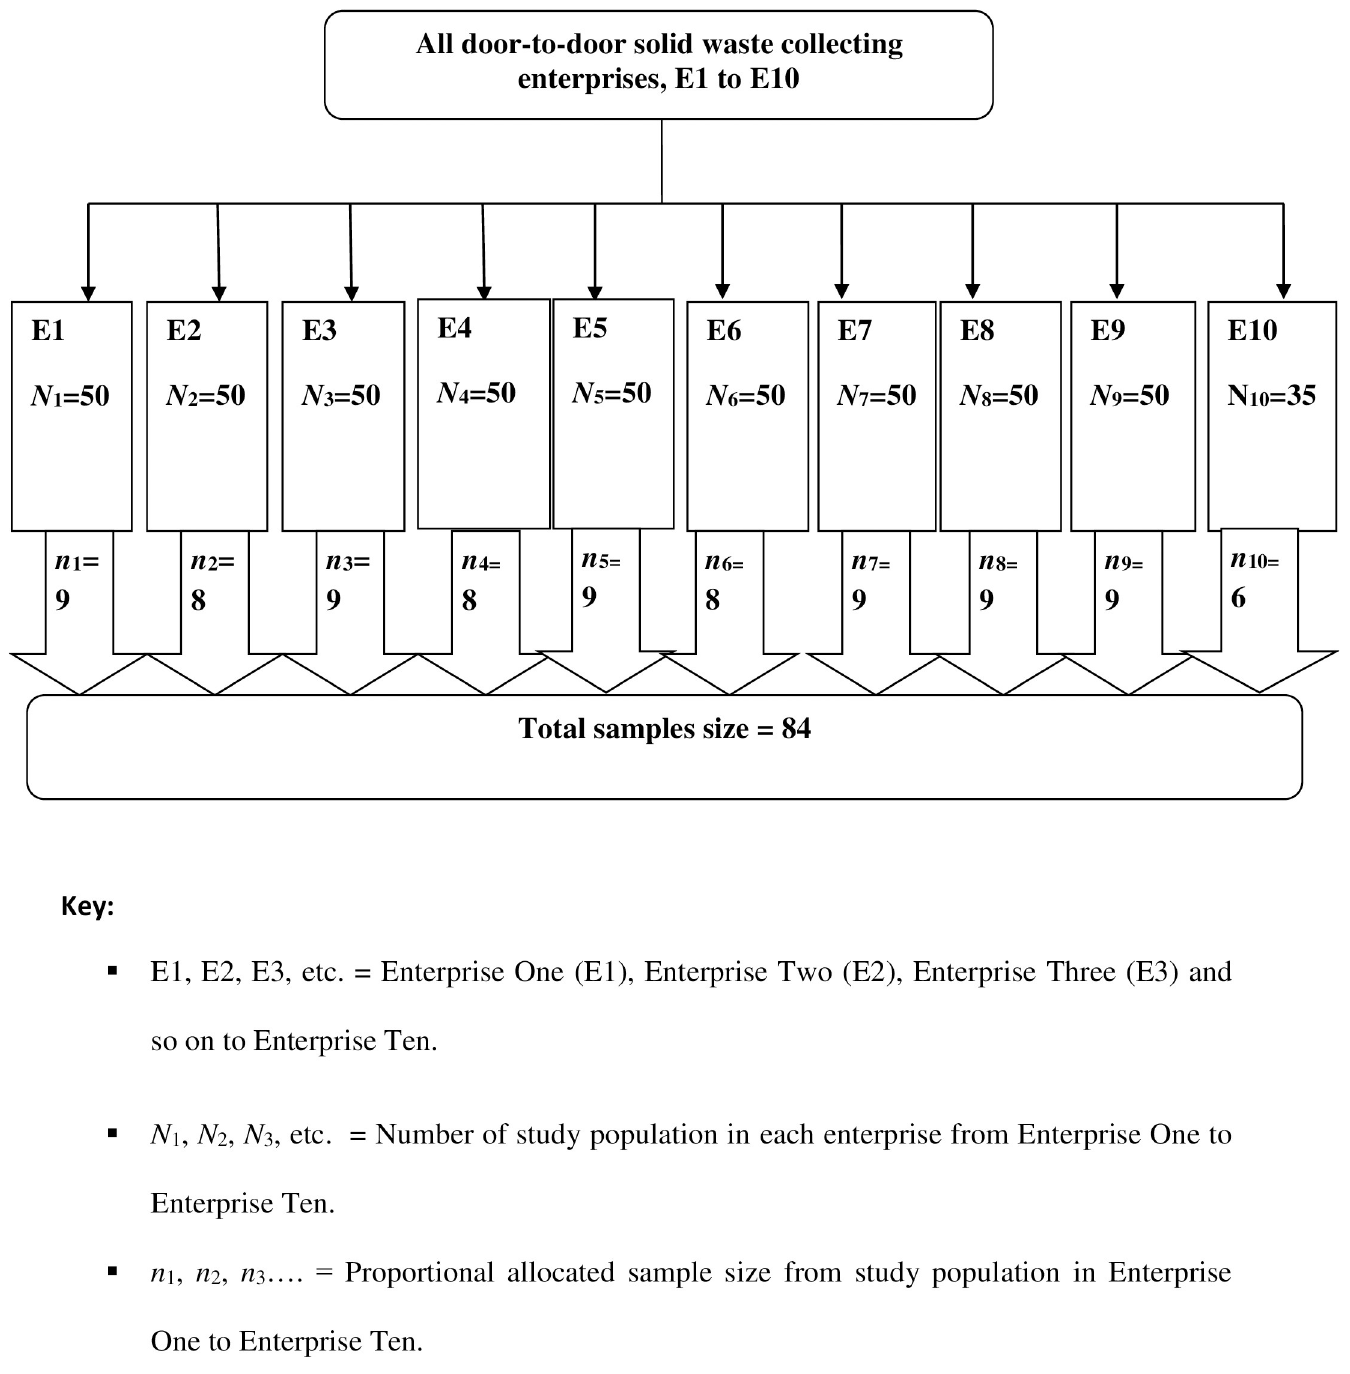
Fig 1. Proportional allocation of sample size among enterprises of door-to-door waste collectors in Dessie City, Ethiopia, March to May 2018. https://doi.org/10.1371/journal.pone.0251621.g001 Data were analyzed using three different binary logistic regression models at 95% CI: the first model (Model I) was used to identify factors associated with ARI among street sweepers, the second model (Model II) was used to identify factors associated with ARI among door-to- door waste collectors, and the third model (Model III) was used for pooled (combined) analysis